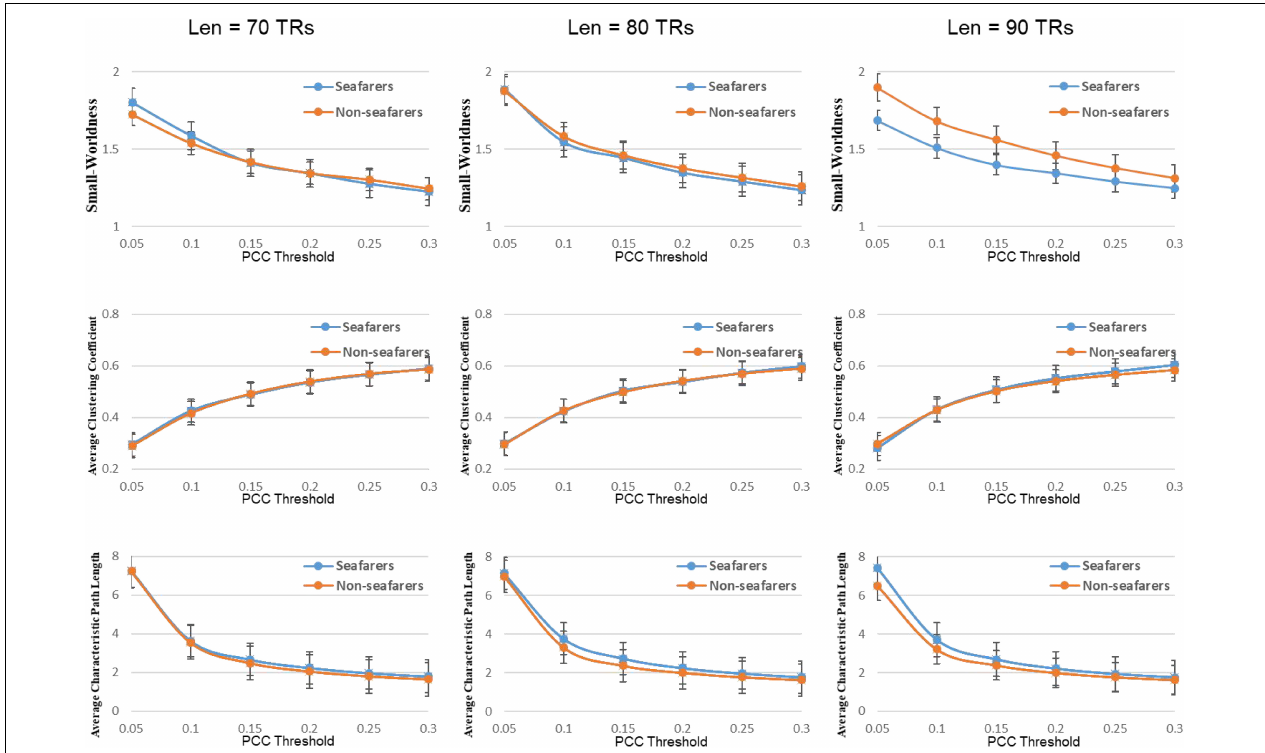
FIGURE 6 | Average values of small world attributes and their parameters of the seafarers and non-seafarers based on brain entropy time series under different window lengths and different thresholds.